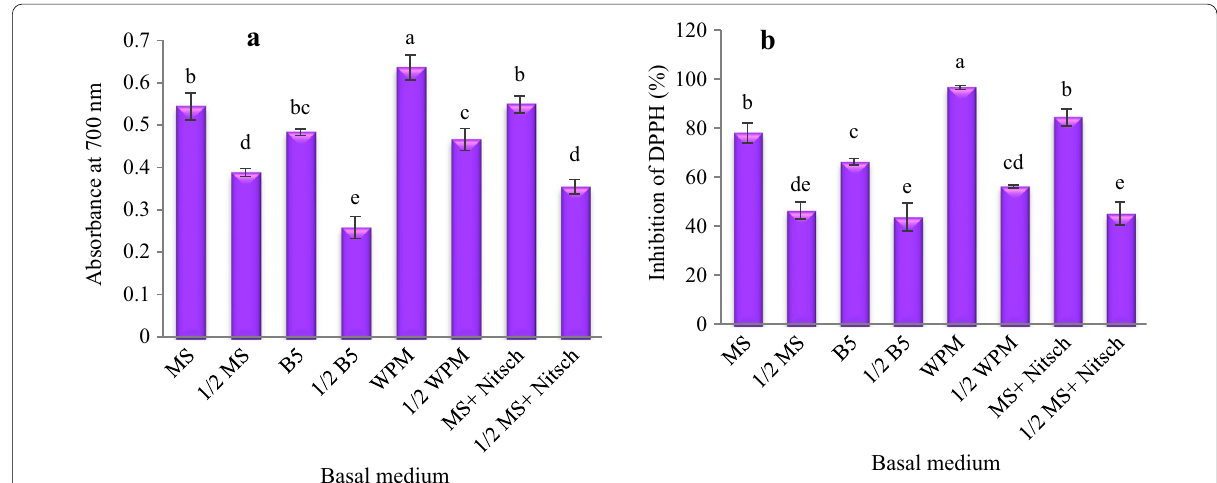
Fig. 8 The influence of the basal medium on antioxidant activity extracts of Corylus avellana callus cultures; reductive potential ( a ), and DPPH